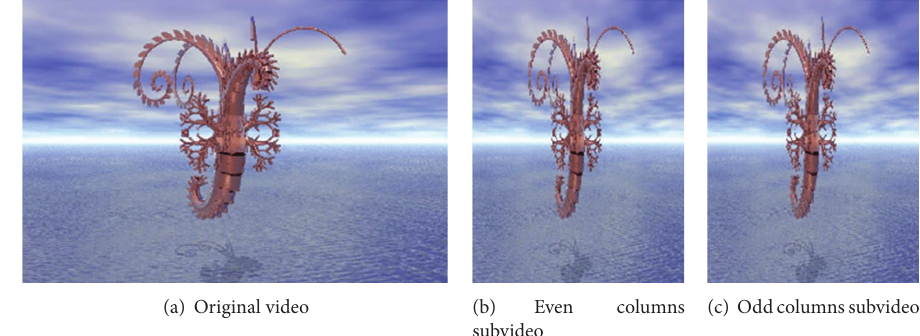
Figure 8: One-level interlacing by columns.